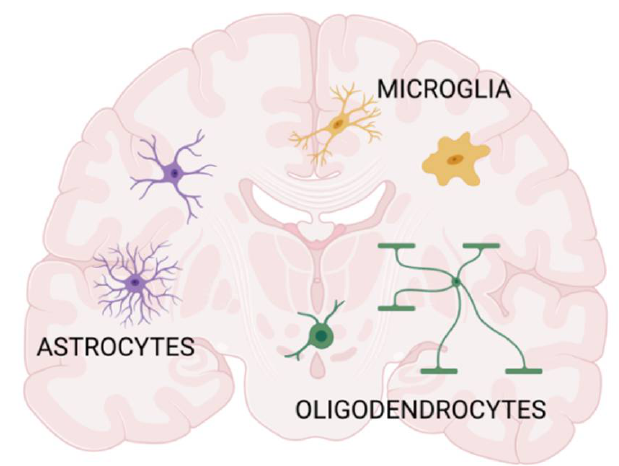
Figure 1. The main types of glial cells of the brain comprise macroglia (astrocytes, oligodendrocytes, and oligodendrocyte progenitors) and microglia. The cells, extracellular matrix, and secreted factors of paracrine signaling participate in intercellular communication and nervous tissue shaping. Figure created with BioRender.com. (accessed on 1 April 2022).